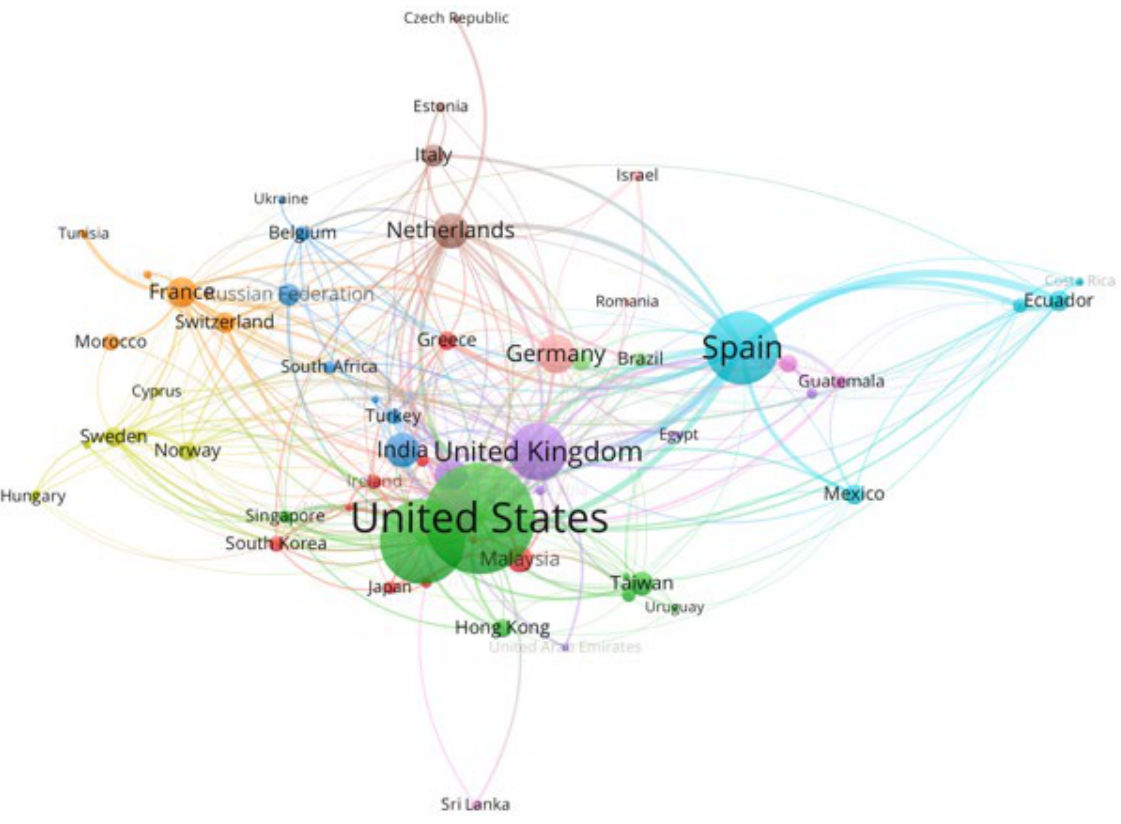
Figure 4. Network visualization map of MOOCs research co-authors by country.